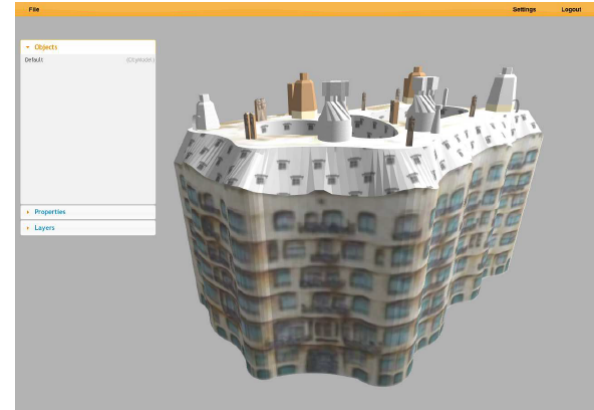
Figure 2: 3D WebGL visualization of the Collada model of ”La Pedrera” (Barcelona) from Google 3D